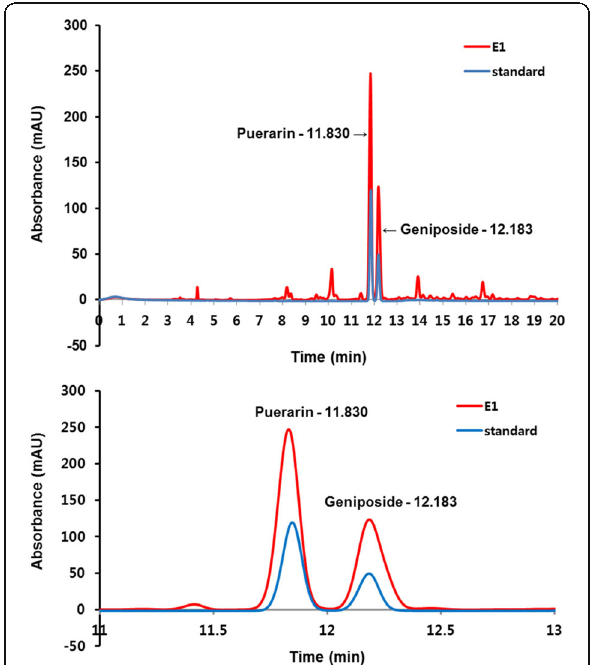
Fig. 1 HPLC chromatograms of the SC-E1 at 240